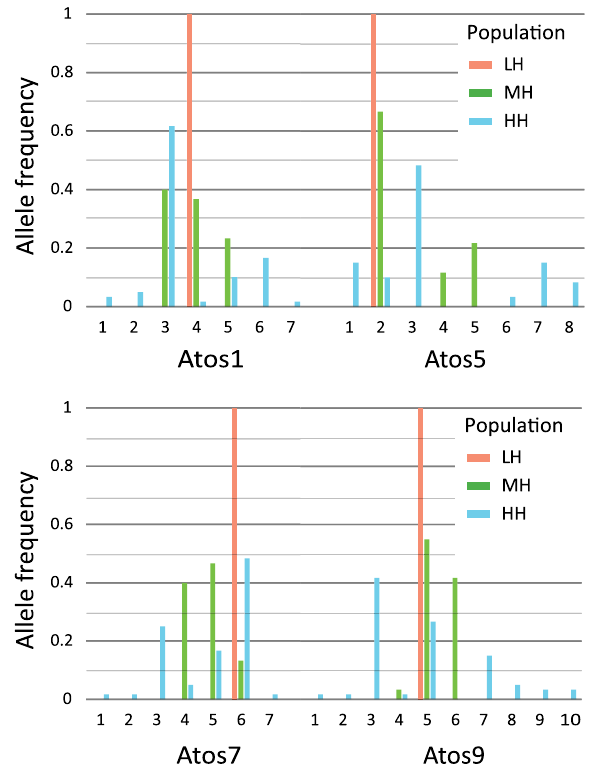
Figure 1. Allele frequency in each tested locus.